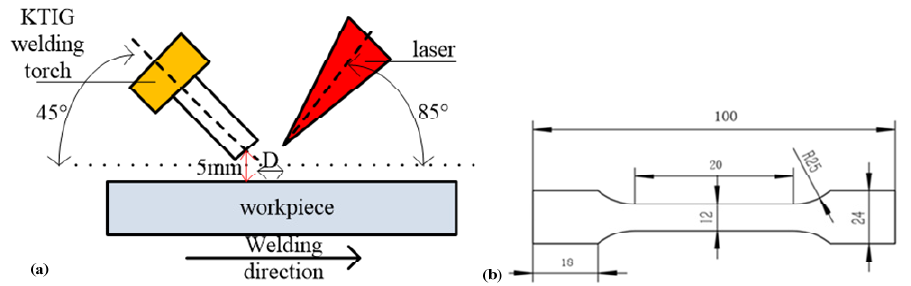
Figure 2. Schematic diagram: ( a ) the distribution of hybrid welding parameters. ( b ) tensile samples.